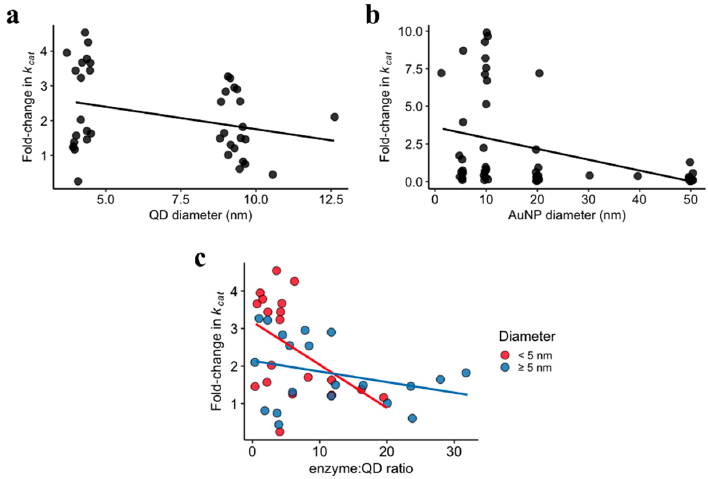
Figure 6. The relationship between fold-change in k cat as a function of quantum dot (QD) and AuNP diameter and enzyme:NP ratio. ( a ) Linear fit of QD diameter and fold-change in k cat . ( b ) Linear fit of AuNP diameter and fold-change in k cat . ( c ) Shows the fold-change in k cat as a function of enzyme: QD ratio colored by small ( < 5 nm) or large ( ≥ 5 nm) diameters.